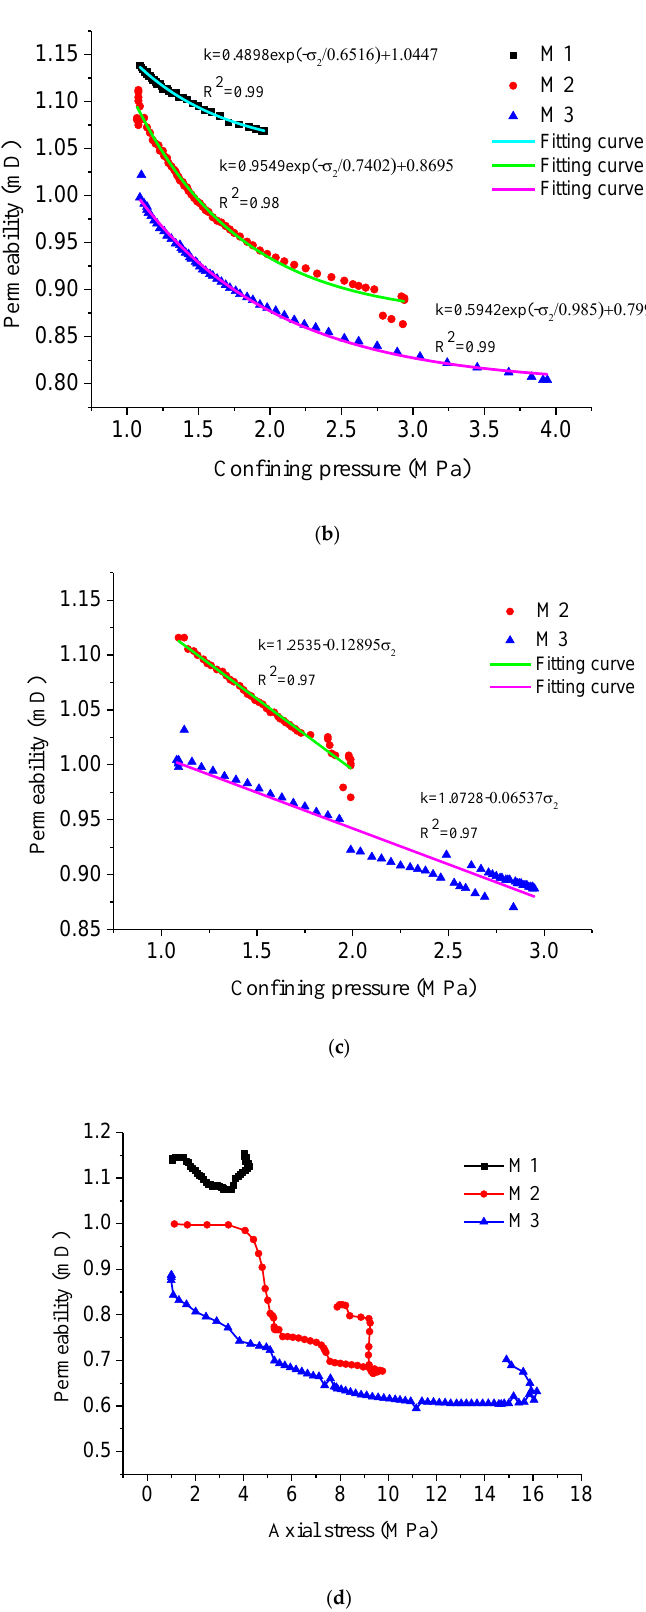
Figure 8. Comparison of permeability evolution under different parameters. ( a ) Unloading axial stress; ( b ) unloading confining pressure; ( c ) loading confining pressure; ( d ) loading to the secondary damage.